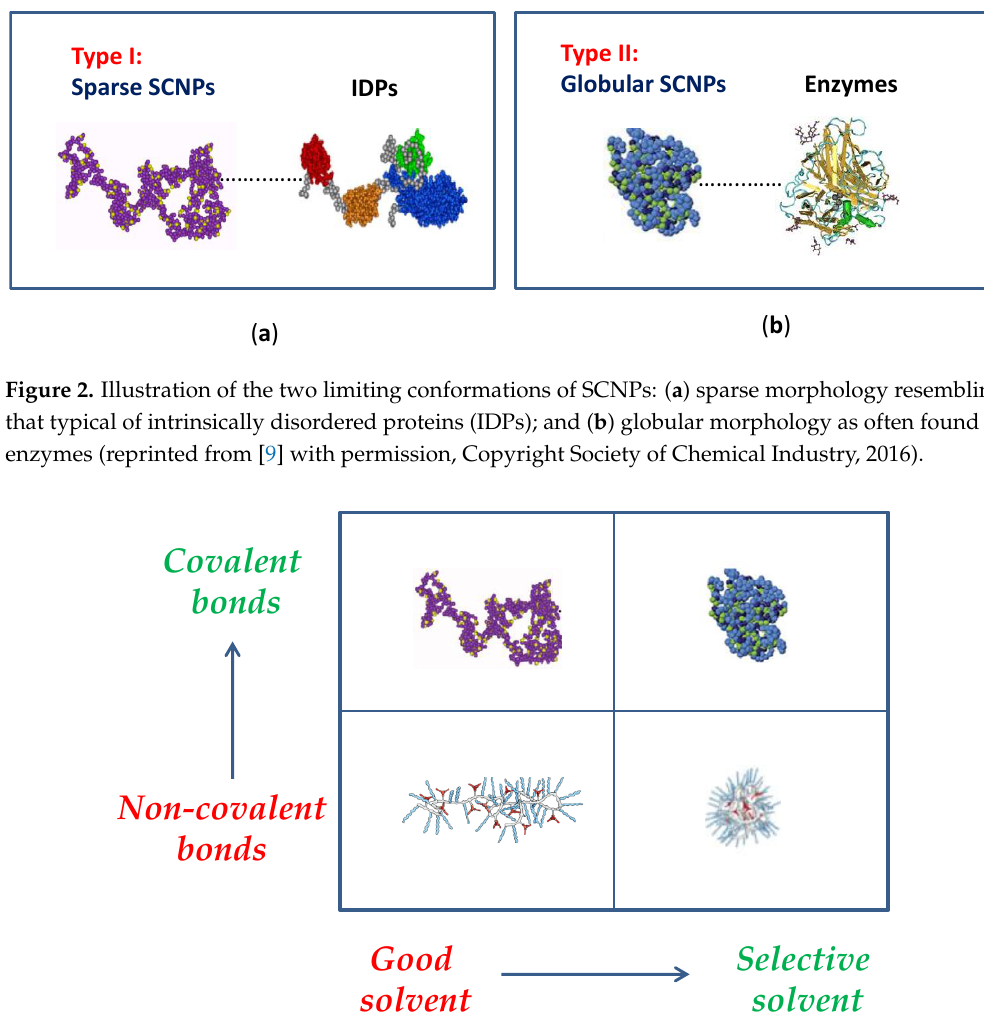
Figure 2. Illustration of the two limiting conformations of SCNPs: ( a ) sparse morphology resembling that typical of intrinsically disordered proteins (IDPs); and ( b ) globular morphology as often found in enzymes (reprinted from [9] with permission, Copyright Society of Chemical Industry, 2016).